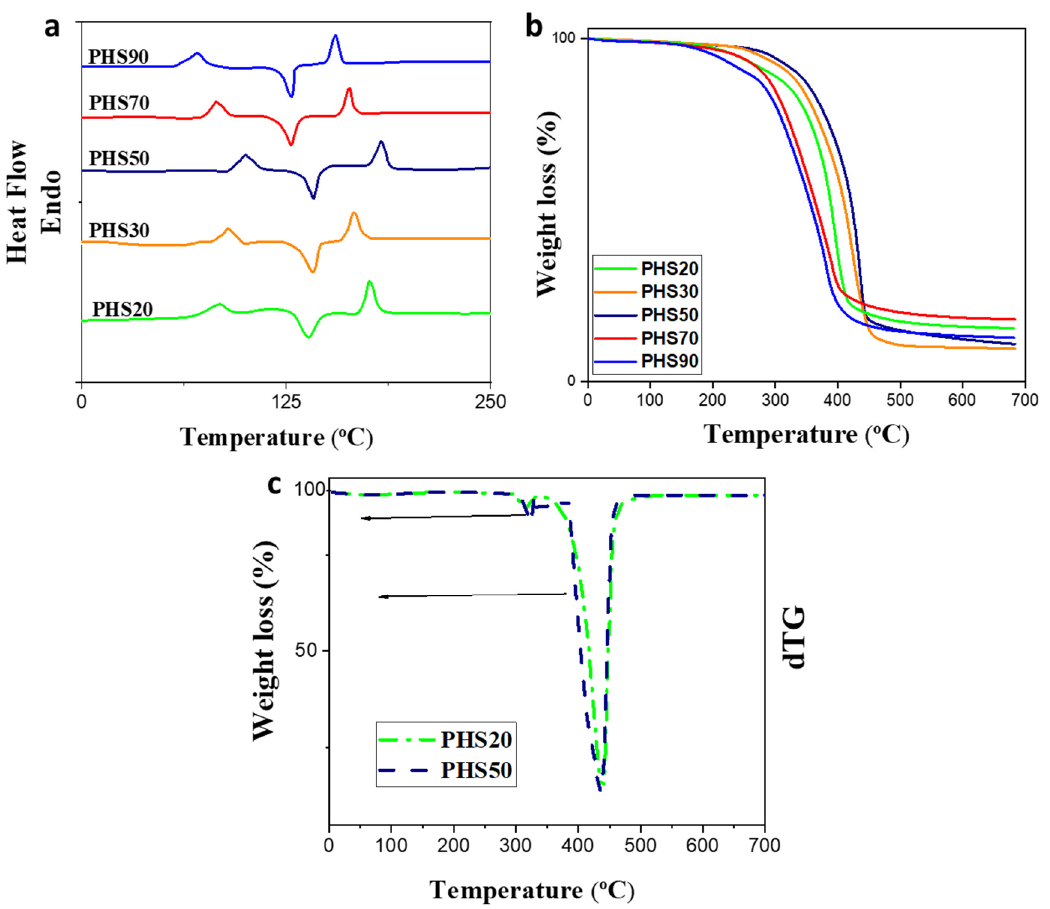
Figure 6. ( a ) DSC and ( b ) TGA curves for copolyesters PHS(20–90), ( c ) differential TGA curves for copolyesters PHS20 and PHS50. Table 4. Thermal analysis results for copolyesters PHS(20–90).